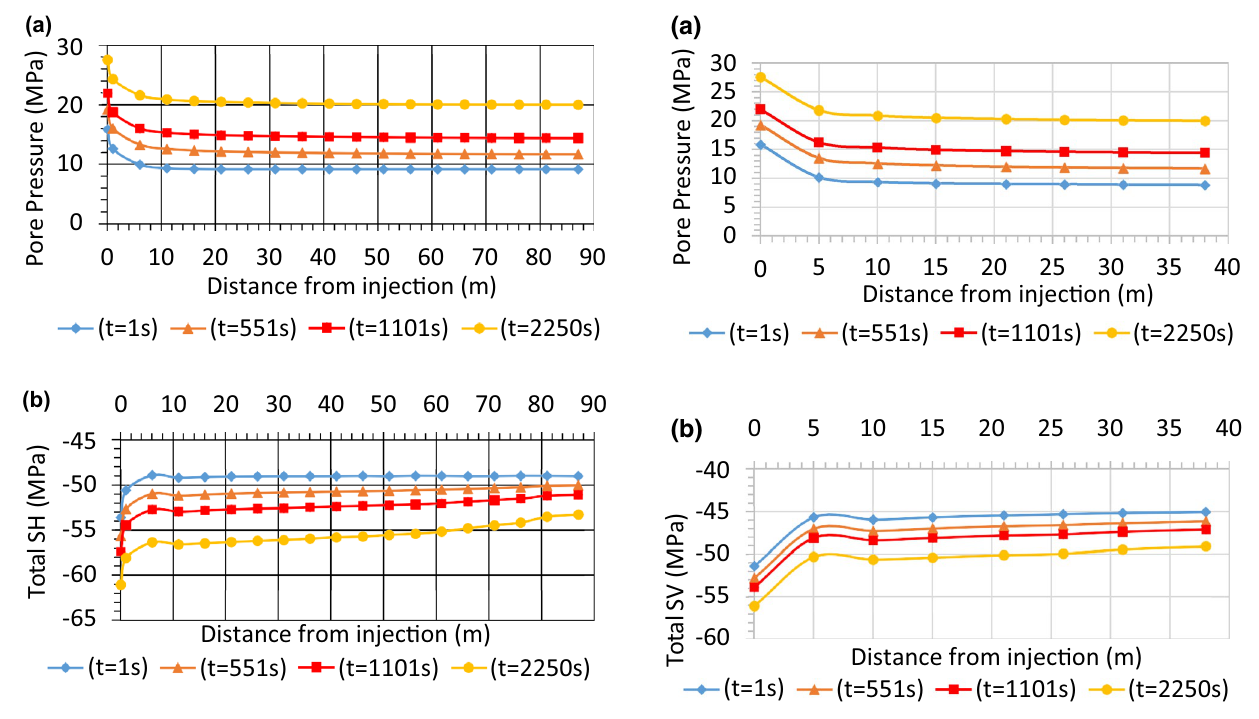
Fig. 8 Case 1 ( k = 23.4 mD): a Pore pressure versus distance and b total maximum horizontal stress versus distance along SRV length from the injection port at various injection times